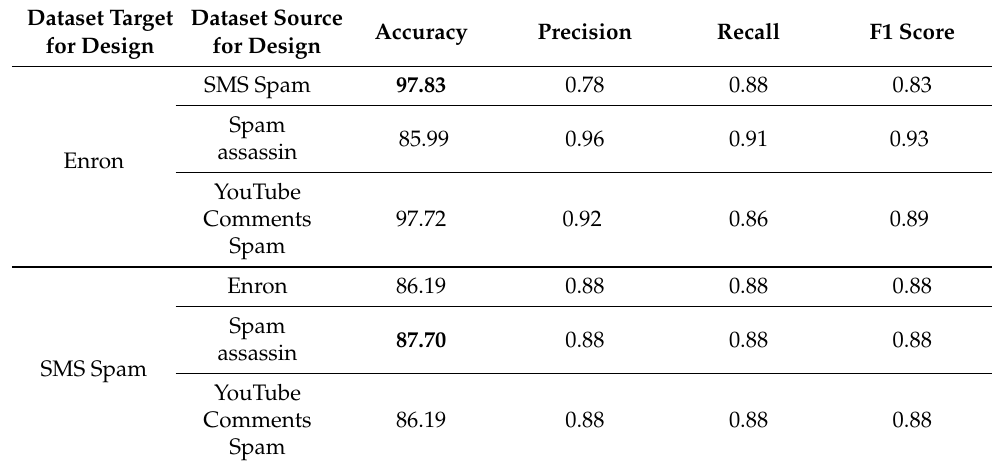
Table 10. Results for reusing pipeline designs created for one spam detection dataset on another. Dataset